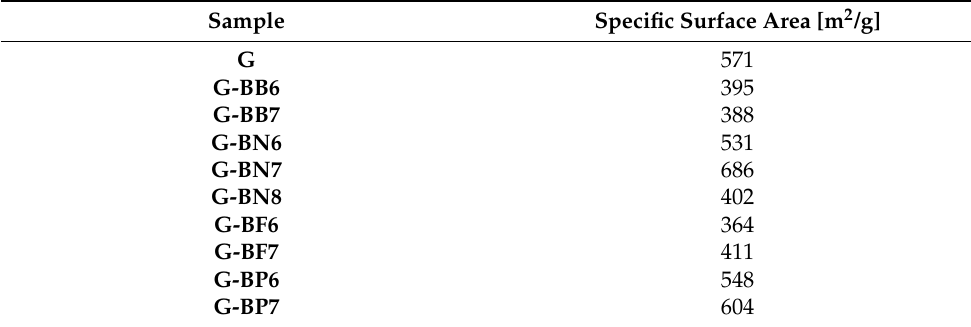
Table 2. Specific surface area calculated for synthesized